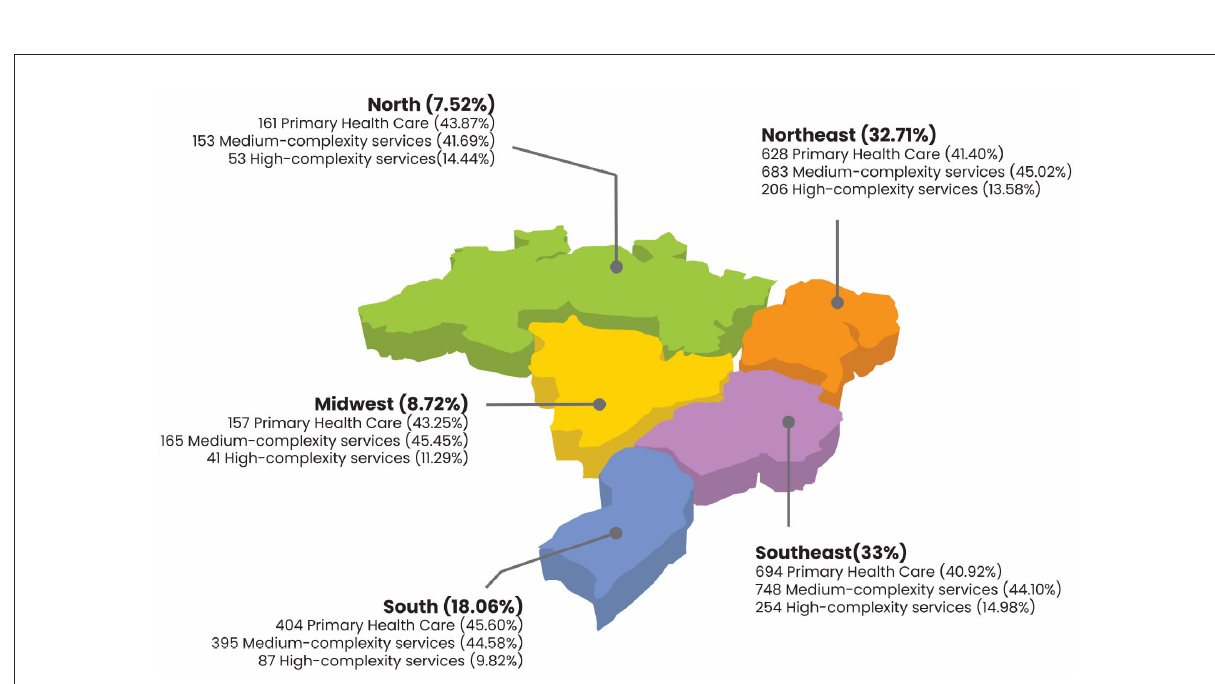
FIGURE5 Trajectory of healthcare professional attendees by level of health care and